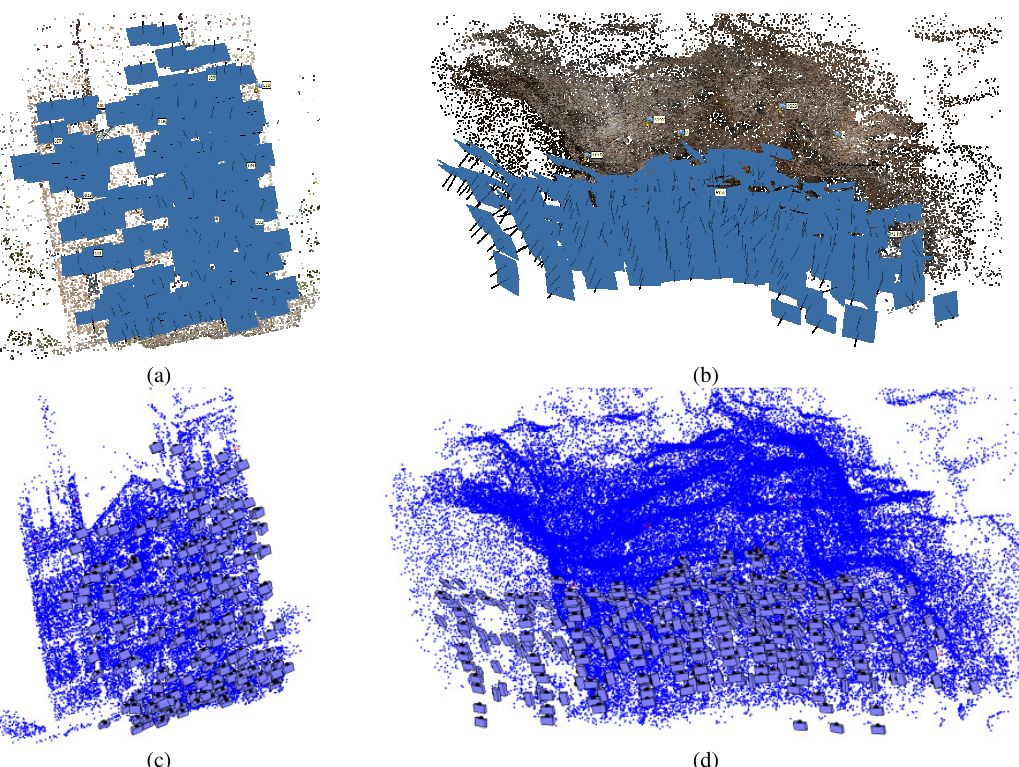
Figure 2. Results of the bundle adjustment process showing the orientation of the photos in PS (top row) and DBAT (bottom row). The St-Pierre results are shown in (a) and (c). The Lacey results are shown in (b) and (d)